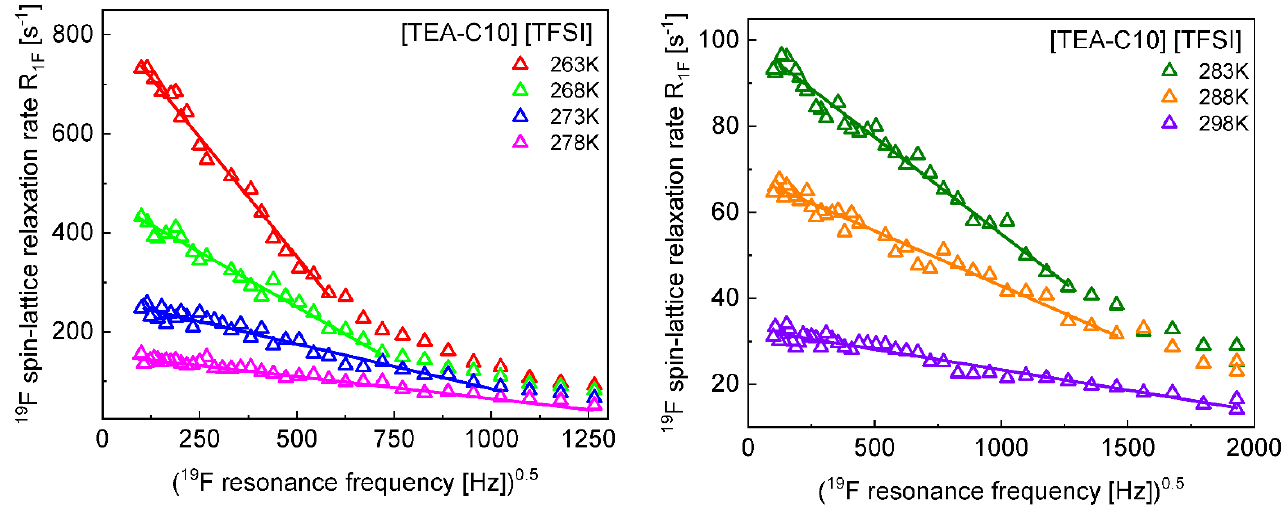
Figure A2. 19 F spin-lattice relaxation data for [TEA − C10] [TFSI] versus the squared root of the resonance frequency; solid lines represent linear fits in the low frequency range.